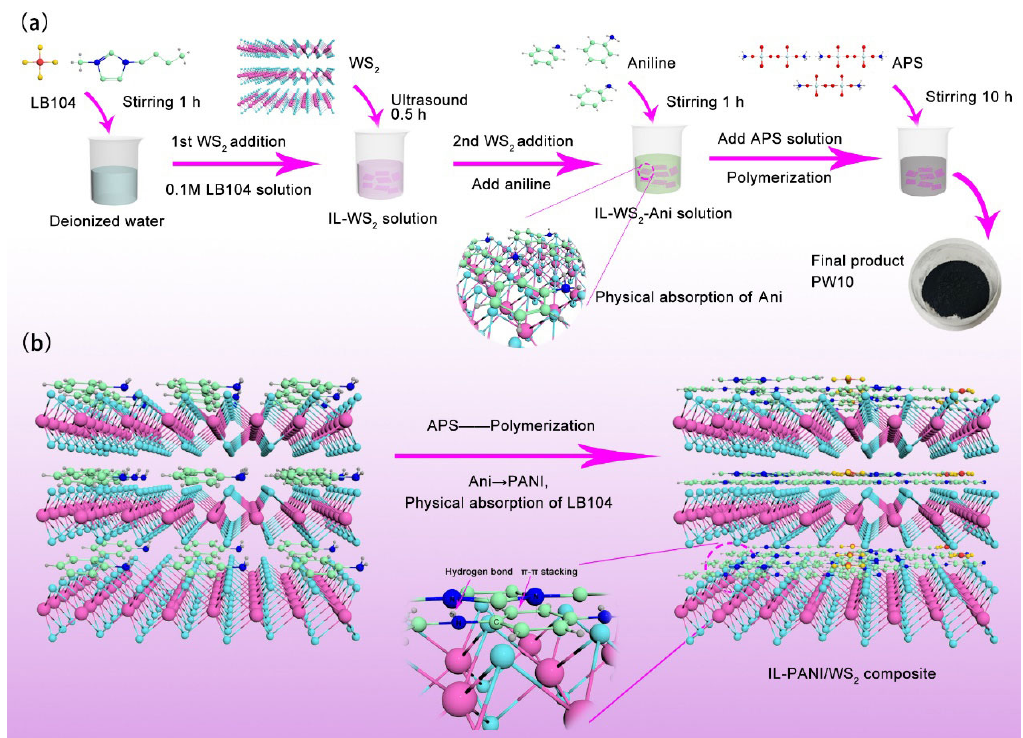
Fig. 1 (a) Schematic illustration of synthesis of IL-PANI/WS 2 composite (PW10). (b) Polymerization mechanism of aniline on surface of WS 2 in LB104